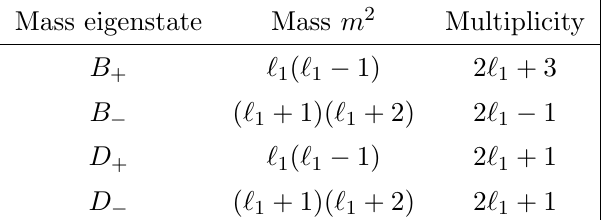
Table 2 . Masses and eigenstates of the complicated bosons in the k 1 k 2 (cid:2) k 1 k 2 block for the case ‘ 2 = 0 and ‘ 1 = 1 ; : : : ; k 1 (cid:0) 1. The case ‘ 1 = 0 and ‘ 2 = 1 ; : : : ; k 1 (cid:0) 1 is obtained by relabeling.